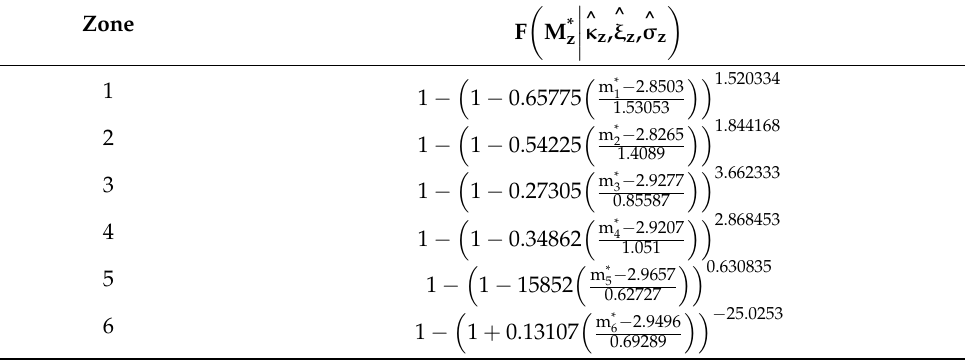
Table 12. The CDF of GPD in Cluster Type II.